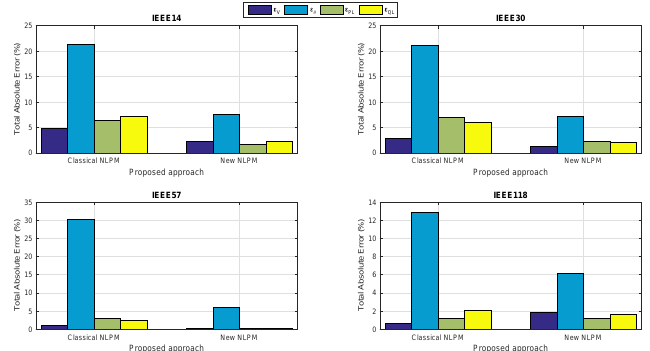
Figure 5. Comparison of total absolute error for IEEE systems.